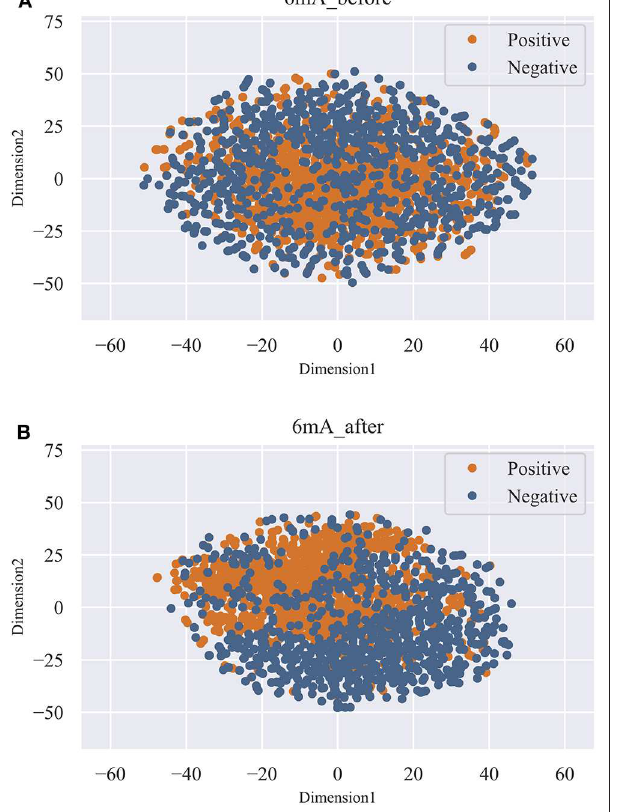
feature representations (NPS and PseDNC) with their